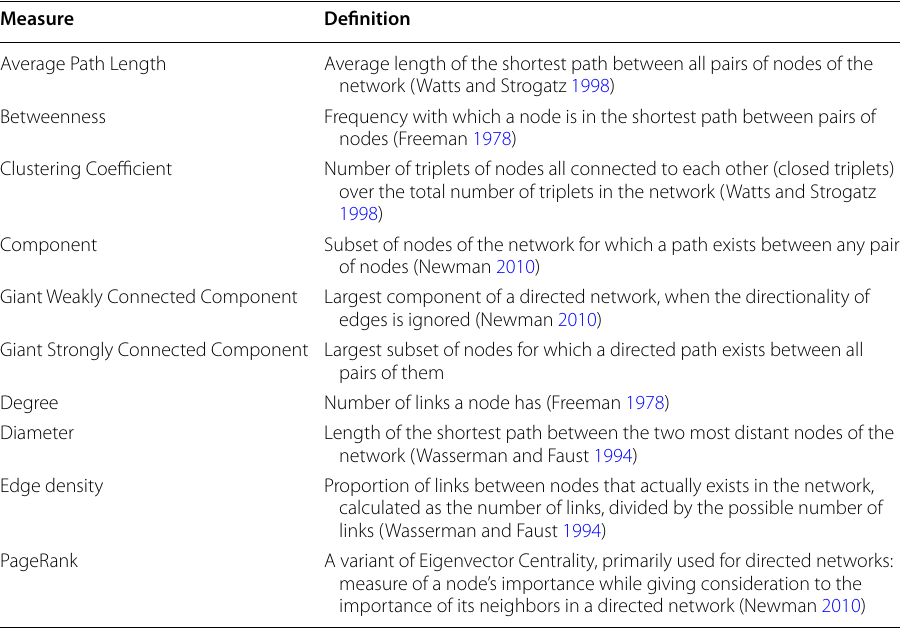
Table 2 Network analysis